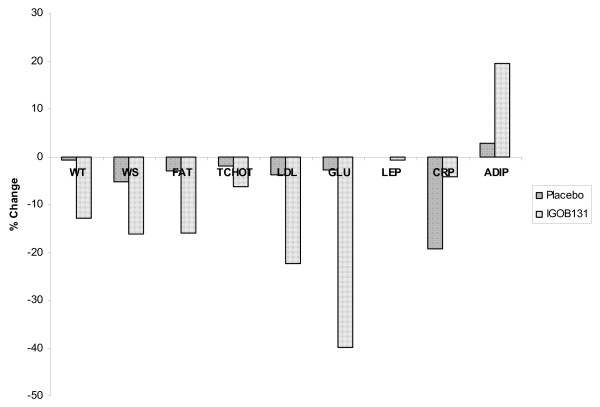
Percentage decrease in body weight (WT), Waist size (WS), Fat (FAT), Total Cholesterol (TCHOL), LDL cholesterol (LDL), Glucose (GLU), Leptin (LEP), C-reactive protein (CRP) and Adiponectin (ADIP) after 10 weeks of use of extract IGO131.